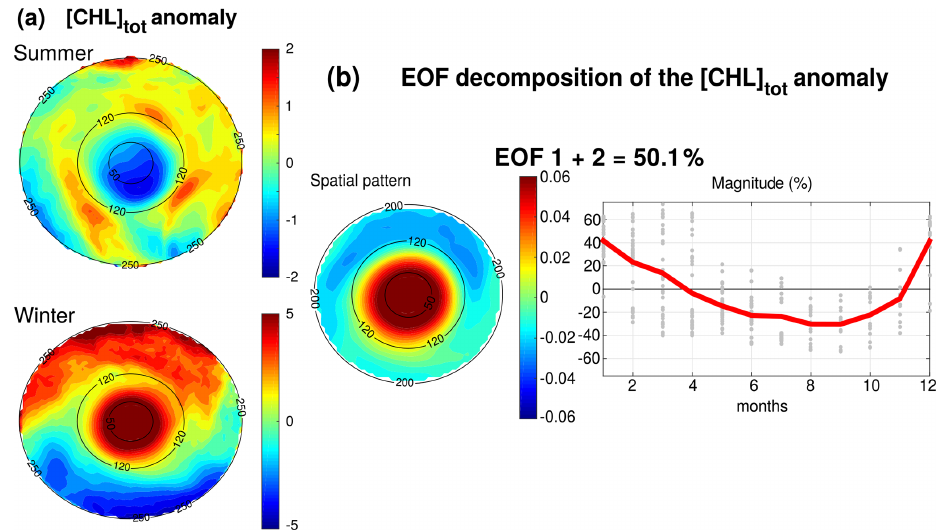
Figure 7. (a) Anomaly of [Chl] tot in summer and winter seasons. Black circles indicate the radius in kilometers. (b) EOF decomposition of the normalized [Chl] tot anomaly. The spatial patterns and monthly magnitude (gray dots; the red line represents their monthly averaged value) of the two first modes are indicated. Modes 1 and 2 were summed together and represent 50.1% of the total variance.